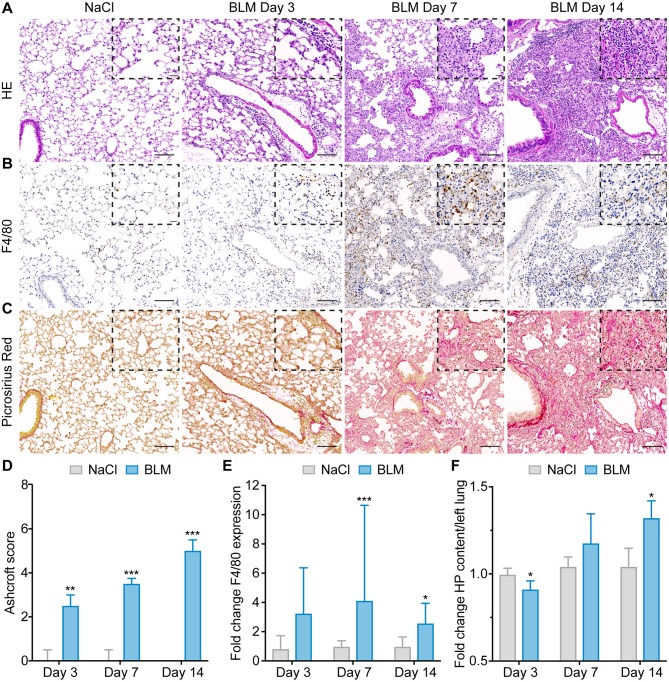
Intratracheal instillation of bleomycin in mice induces progressive lung remodeling characterized by increased numbers of macrophages. (A) Representative images of lung sections from saline-treated controls and BLM-treated mice at days 3, 7, and 14 stained with hematoxylin and eosin (HE), (B) the murine macrophage marker F4/80 (brown), and (C) Picrosirius Red (collagen = red). (D) Semi-quantitative assessment of lung fibrosis by Ashcroft score. (E) Semi-quantification of pulmonary macrophages by automatic image analysis of F4/80 expression. (F) Quantification of left lung collagen content by hydroxyproline (HP) assay. For (A–C) representative pictures at 100× magnification (scale bars: 100 μm) and at higher magnification (400×, scale bars: 20 μm) are shown. For (D–F) data are presented as medians ± IQR. For statistical analysis, the Mann–Whitney U-test was applied (*p < 0.05, **p < 0.01, ***p < 0.001). For all experiments: n = 4–6 for saline controls and n = 6–10 for BLM-treated mice.